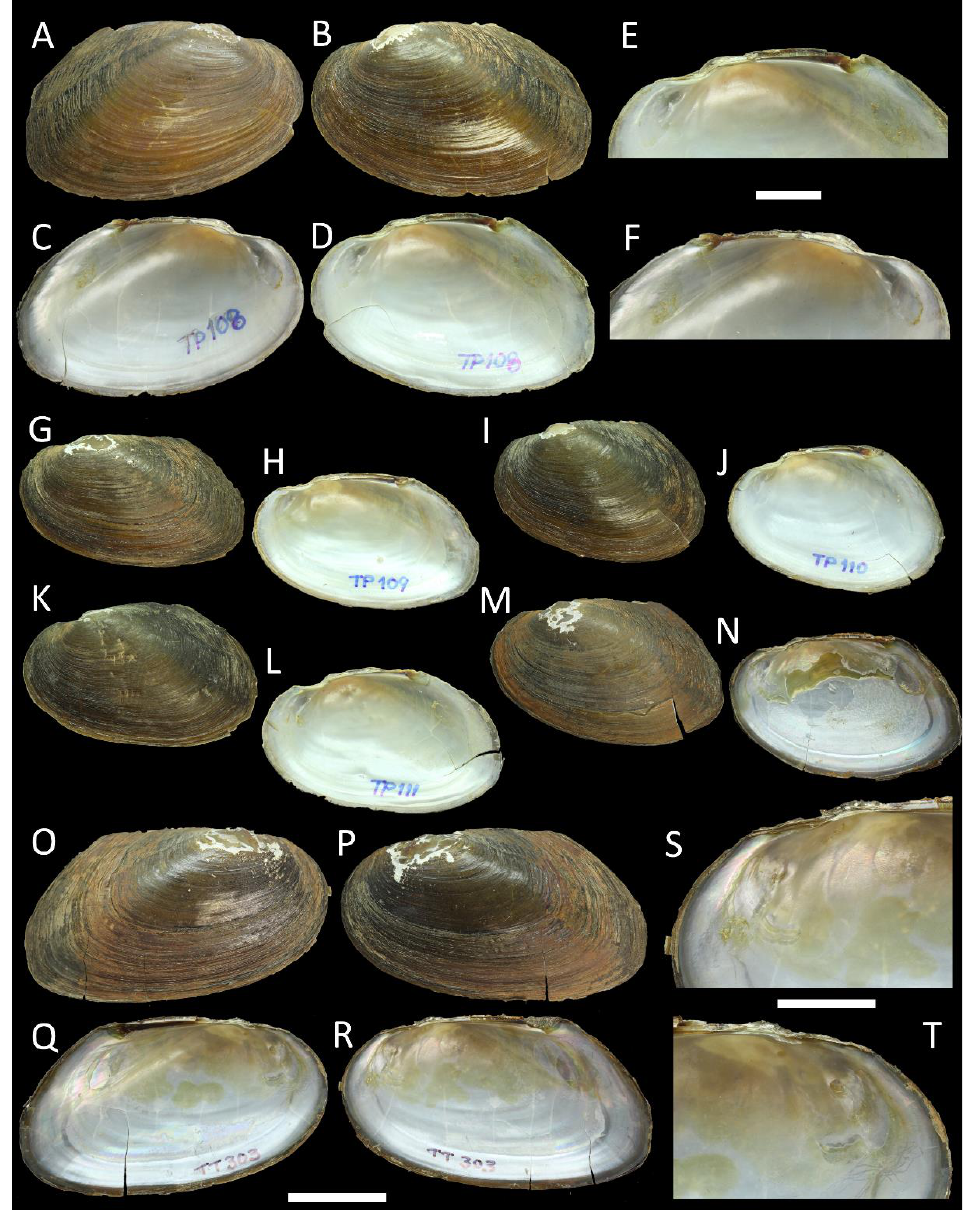
Figure 3. Shells of Monodontina from Southern Thailand. ( A – F ) Monodontina vondembuschiana tapienica ssp. nov. , holotype RMBH biv 1272/1, Main Klong Min, Nakhon Si Thammarat Province: right ( A ) and left ( B ) valve view, inside view of left ( C ) and right ( D ) valve, interior view zoom fragment of right ( E ) and left ( F ) valve; ( G , H ) M. v. tapienica ssp. nov. , paratype RMBH biv 1272/2, the same locality: ( G ) left valve view, ( H ) inside view of right valve; ( I , J ) M. v. tapienica ssp. nov. , paratype RMBH biv 1272/3, the same locality: ( I ) left valve view, ( J ) inside view of right valve; ( K , L ) M. v. tapienica ssp. nov. , paratype RMBH biv 1272/4, the same locality: ( K ) left valve view, ( L ) inside view of right valve; ( M , N ) M. v. thasaenica ssp. nov. , paratype RMBH biv 1321/2, Main Klong Thasae, Chumphon Province: ( M ) left valve view, ( N ) inside view of right valve; ( O – T ) M. v. thasaenica ssp. nov. , holotype RMBH biv 1321/1, the same locality: right ( O ) and left ( P ) valve view, inside view of left ( Q ) and right ( R ) valve, anterior fragment of right ( S ) and left ( T ) valve. Scale bar = 20 mm ( A – D , G – R ); scale bar = 10 mm ( E , F , S , T ). Photos: Ekaterina S.